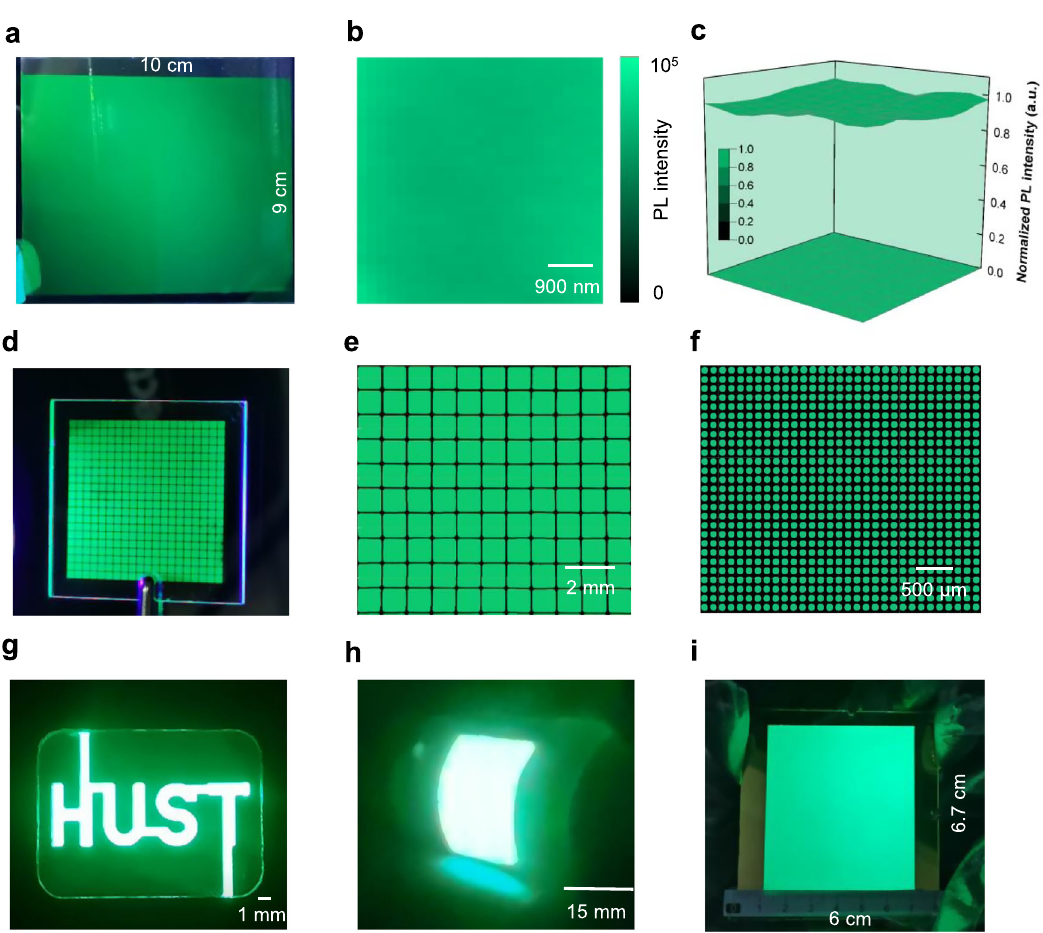
Fig. 4 Potential of thermally evaporated PeLED for display application. a PL image of 90 cm 2 Cs-Pb-Br fi lm fabricated by thermal evaporation. b , c The spatial distribution of PL intensity for the micro area (5 μ m × 5 μ m) and macro area (90 cm 2 ). d The PL photo of CsPbBr 3 fi lm with 900 μ m × 900 μ m pixels. e , f The images of fl uorescence microscopy characterization for the patterned perovskite fi lm. g EL photo of PeLED with a “ HUST ” pattern (48 mm 2